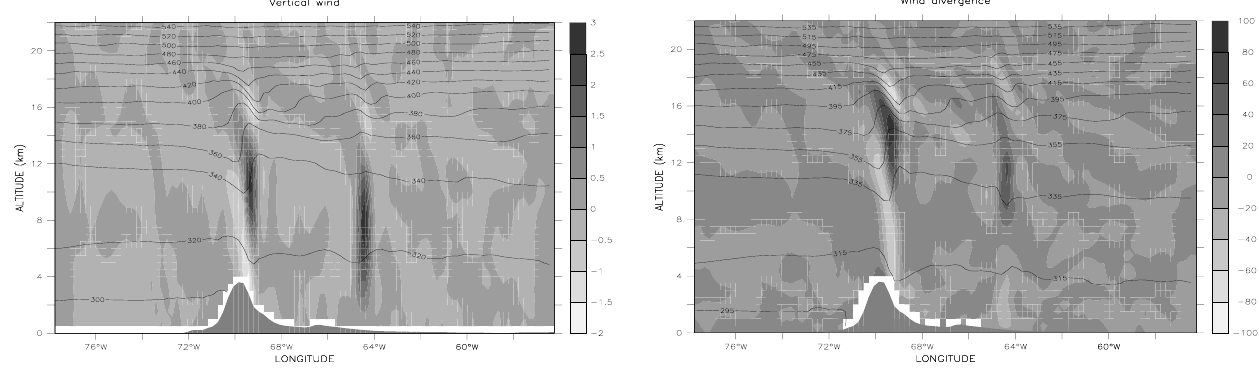
Fig. 20. Case 4: Results of the WRF simulations. Longitude-altitude cross sections at latitude − 34.28N. Left: Vertical wind velocity (ms − 1) and isentropes (K). Right: Horizontal wind divergence (s − 1) and isentropes